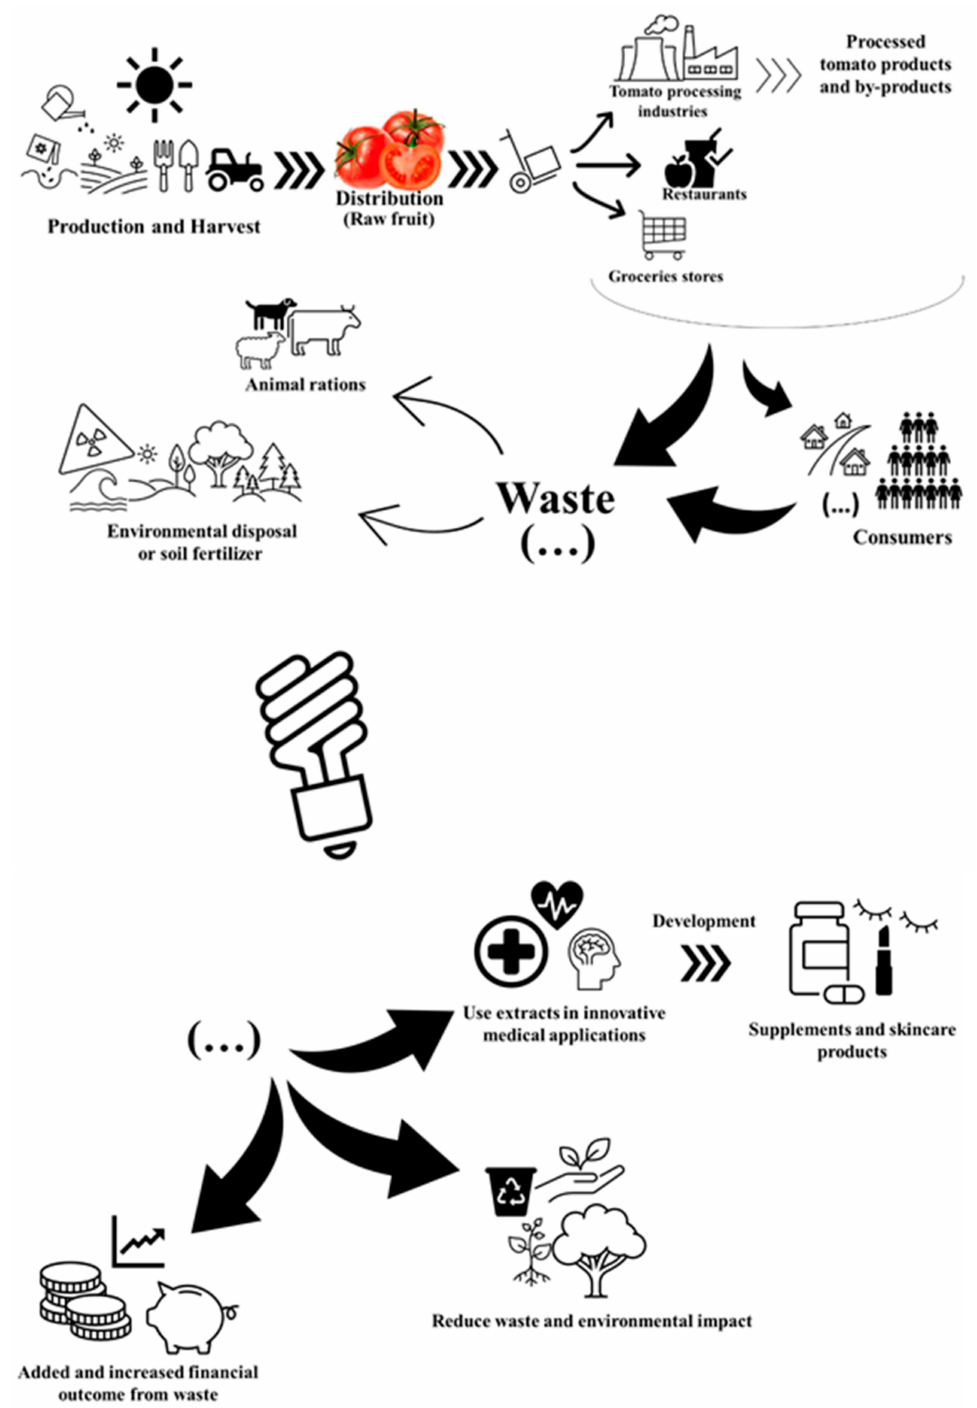
Figure 4. Schematic representation of traditional tomato production and processing circuit versus added-value